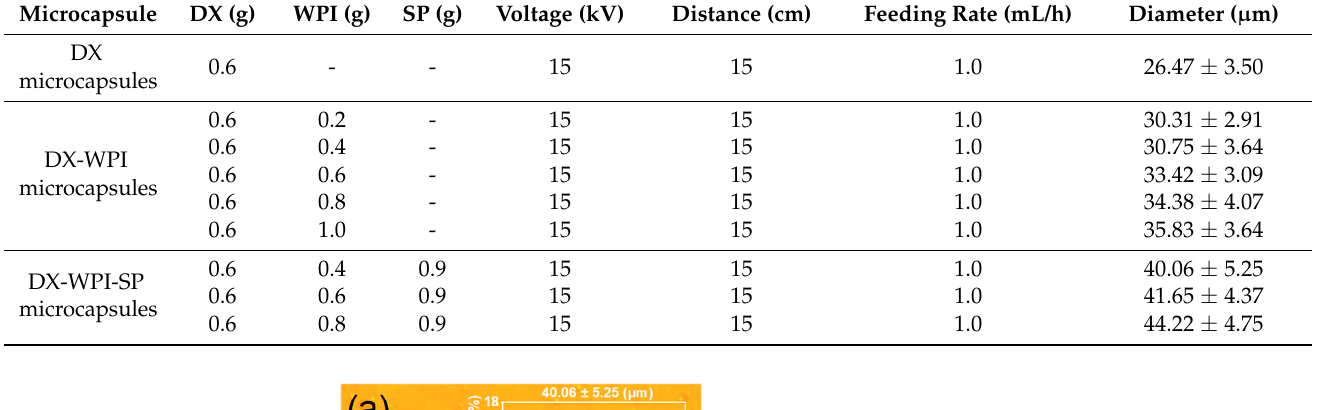
Table 1. Operation parameters for various microcapsules via electrospraying and the diameter of as-prepared microcapsules.